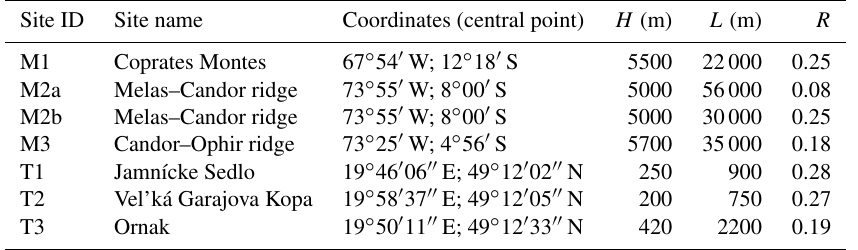
Table 1. Ridge location and parameters in the three Valles Marineris sites and the three Tatra sites. The reason for distinguishing between 2a and 2b is given in Sect. 4.